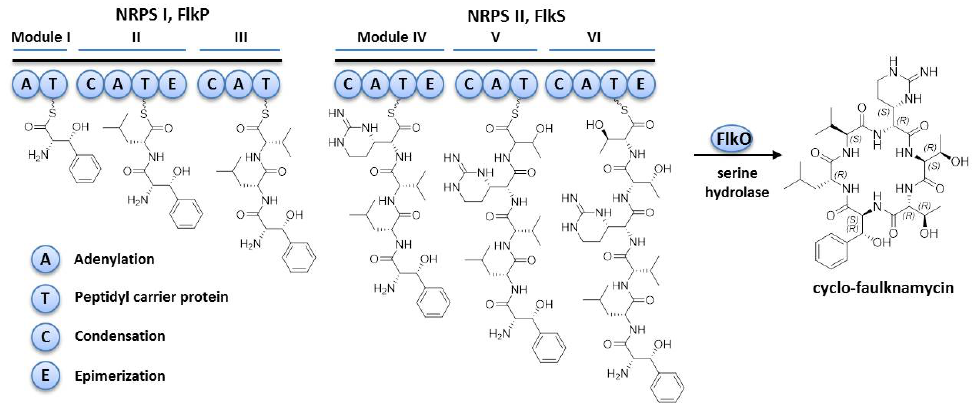
Figure 4. Proposed biosynthesis of cyclofaulknamycin.